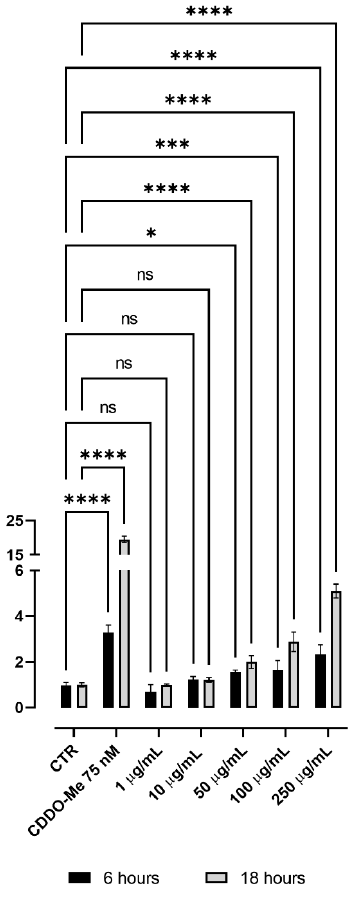
Figure 3. Dose-dependent effect of TAP on NRF2 nuclear translocation. NRF2 activation was tested using NRF2/ARE Responsive Luciferase Reporter HEK293 stable cell line incubated for 6 and 18 h with TAP in a concentration range between 1 and 250 µ g/mL. CDDO-Me 75 nM was used as a pos- itive control. Statistical analysis was calculated by two- way ANOVA with Dunnett’s multiple com- parison test, with individual variances computed for each comparison (* p < 0.05, *** p < 0.001, **** p < 0.0001, ns: not significant).